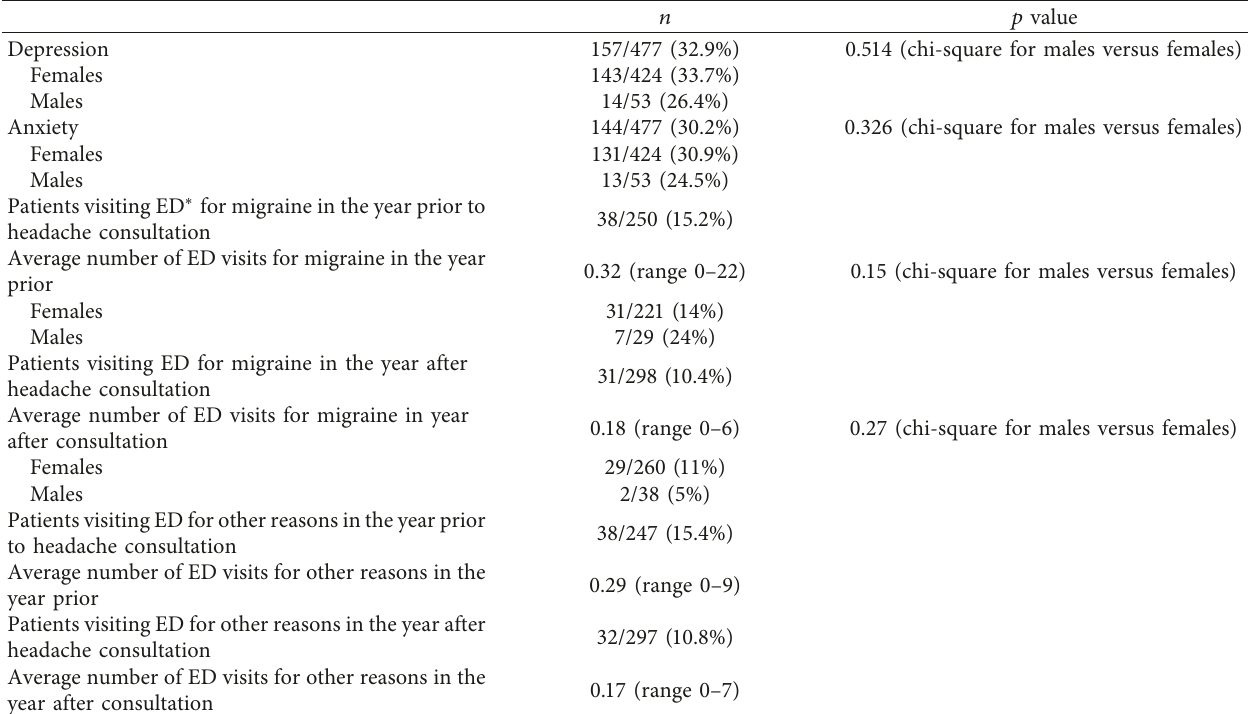
Table 4: Prevalence of comorbidities and measures of healthcare use in 477 patients with